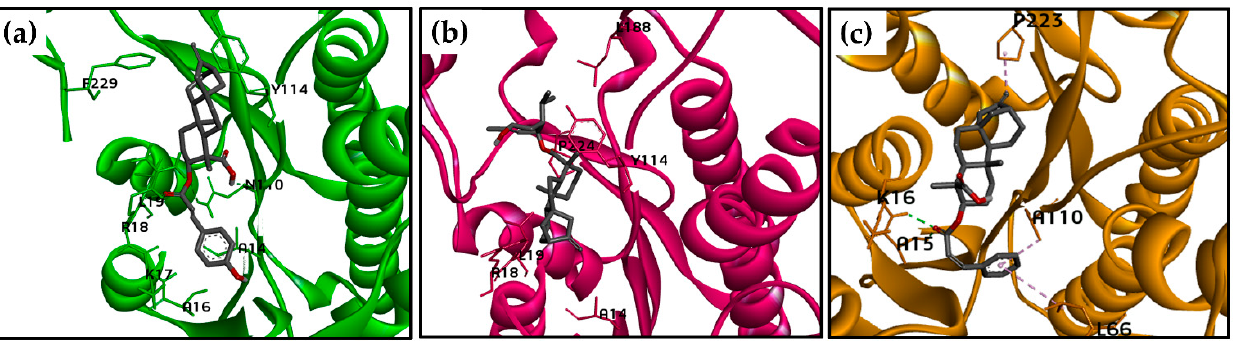
Figure 5. Docking formations between a structure 302 in the active site of ( a ) Lp PTR1, ( b ) Lb PTR1, and ( c ) La PTR1. Labels: H-bonds (green), π -alkyl interactions (purple). Table 5. VINA scores and interactions of structure 302 , PMA and DHB with amino acid residues of Lp PTR1, Lb PTR1, and La PTR1. Critical interactions are highlighted in bold font.